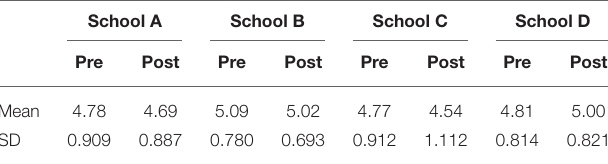
TABLE 10 | Results from the pre- and post-test questionnaires for motivational variables for Schools A–D.